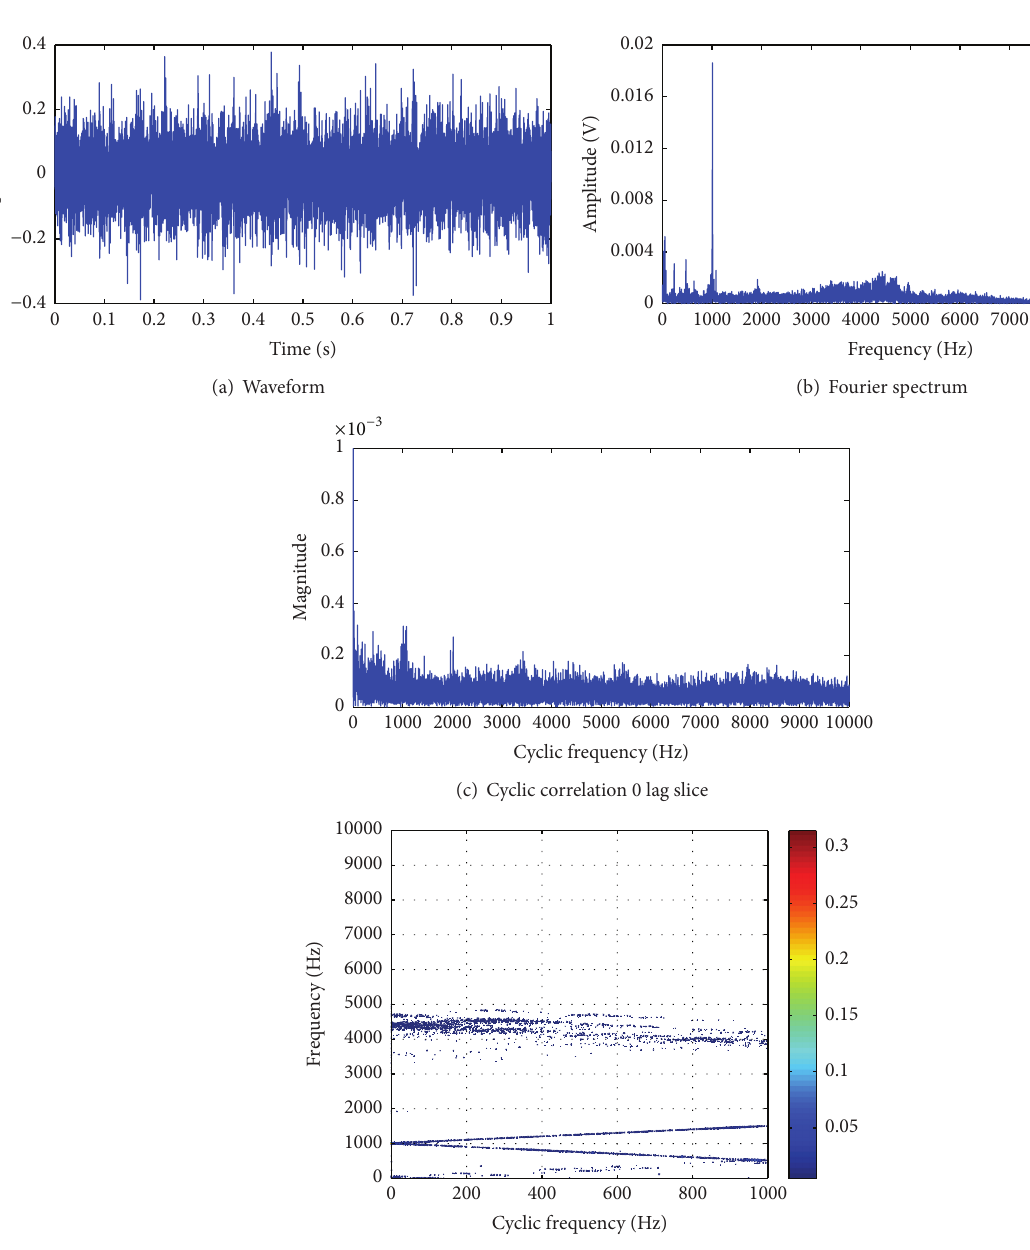
Figure 7: Normal bearing